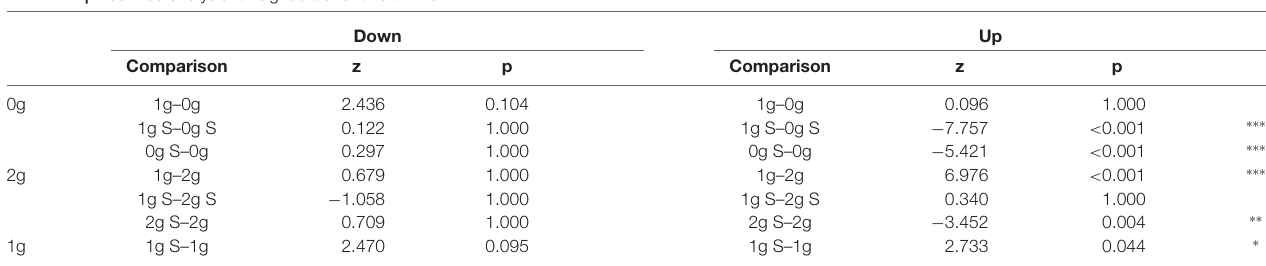
TABLE 1 | Post hoc analysis for signed deviations of hits. Down Up Comparison